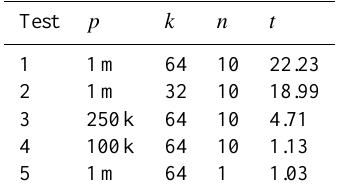
Table 1. Speeds t (min) of K -means in terms of parameters, cluster number k , pixel number p , and nstart n . The K -means algorithm run time is less sensitive to cluster number (test 1,2) than to pixel number (test 1, 3). Speed up is obtained by sampling (test 4+5 = 2.16min) and represents approximately a ten fold speed up based on 10 : 1 sampling